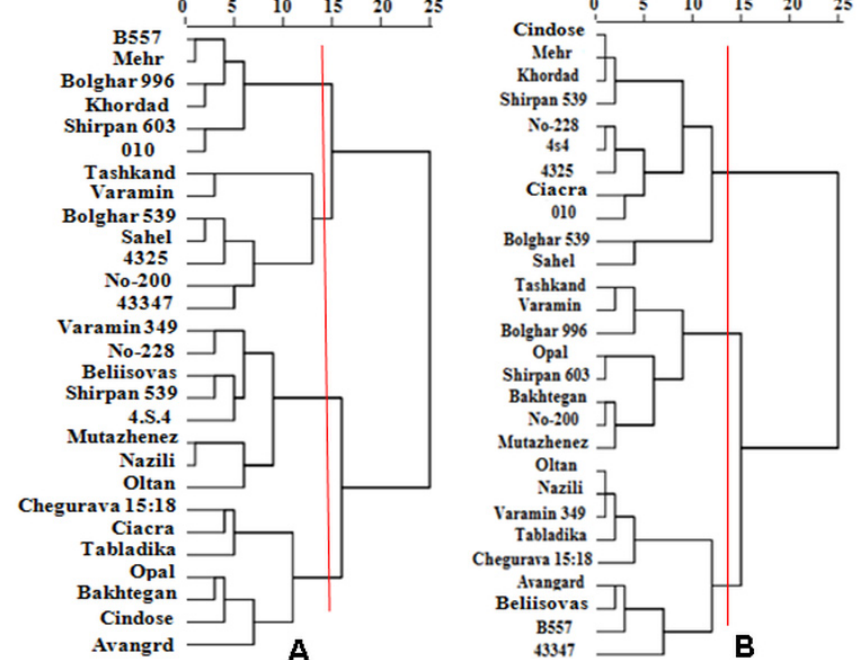
Fig. 1. Cluster analysis dendrogram of 28 cotton commercial cultivars based on agronomic traits (A. Control B. 140 Mm NaCl)